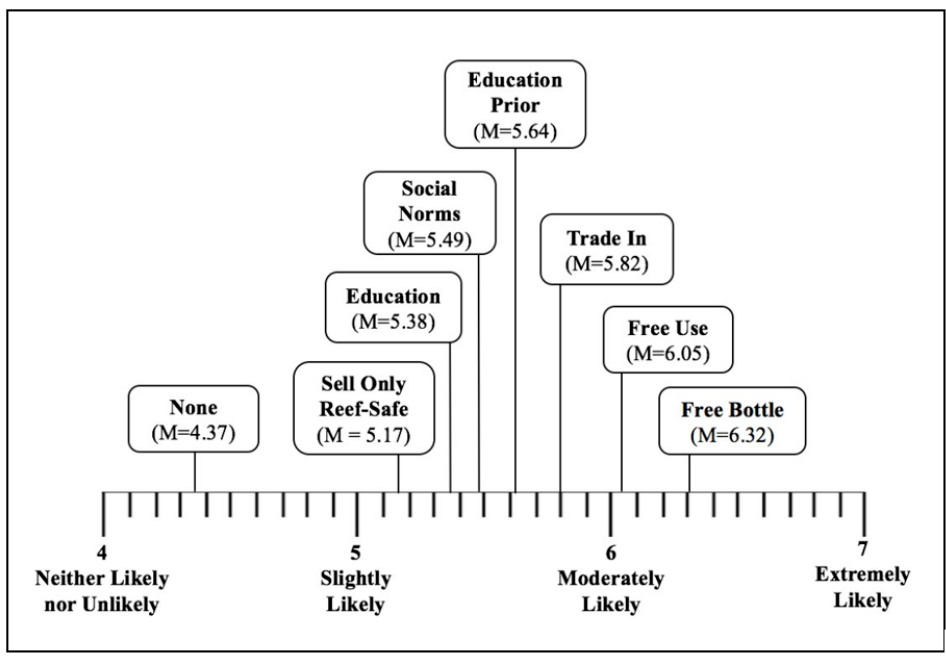
Figure 3. Level of Intention under proposed hotel practices. N = 400. Intention measured on a 7-point scale (1 = extremely unlikely and 7 = extremely likely).